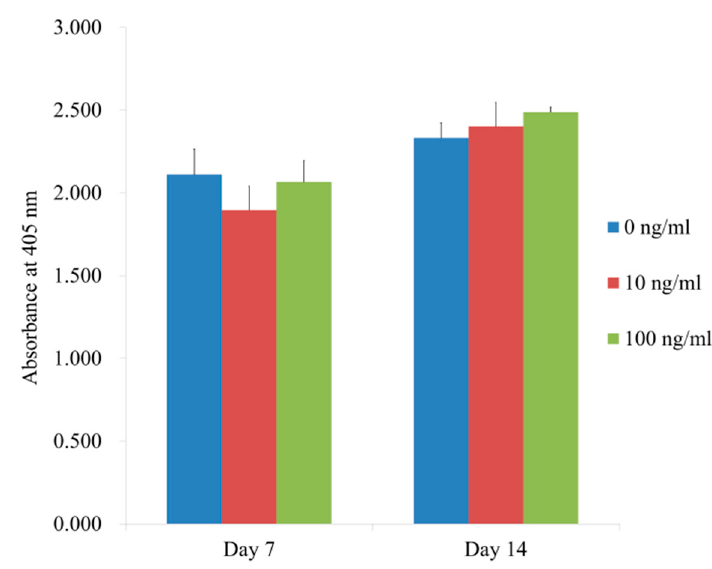
Figure 5. Alkaline phosphatase activity on Days 7 and 14.